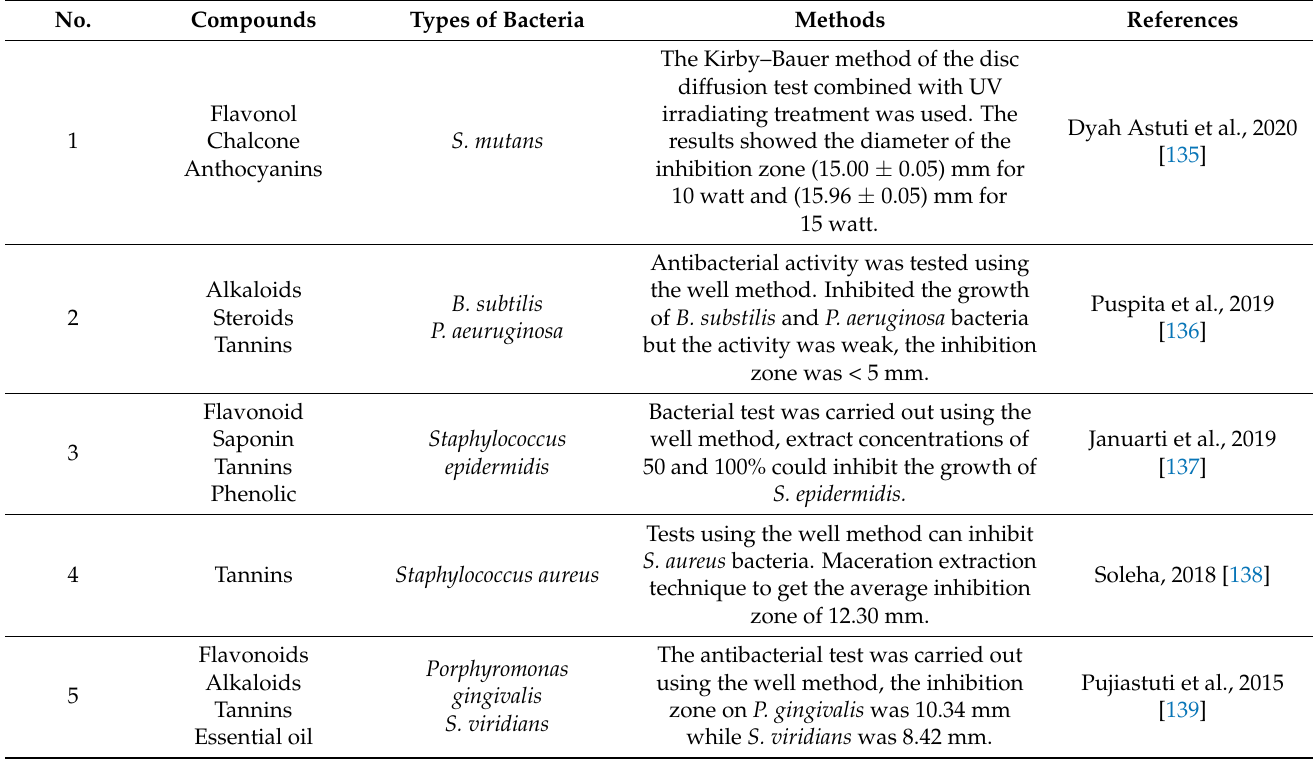
Table 3. Antibacterial activity methods of red betel extract ( P. crocatum Ruiz and